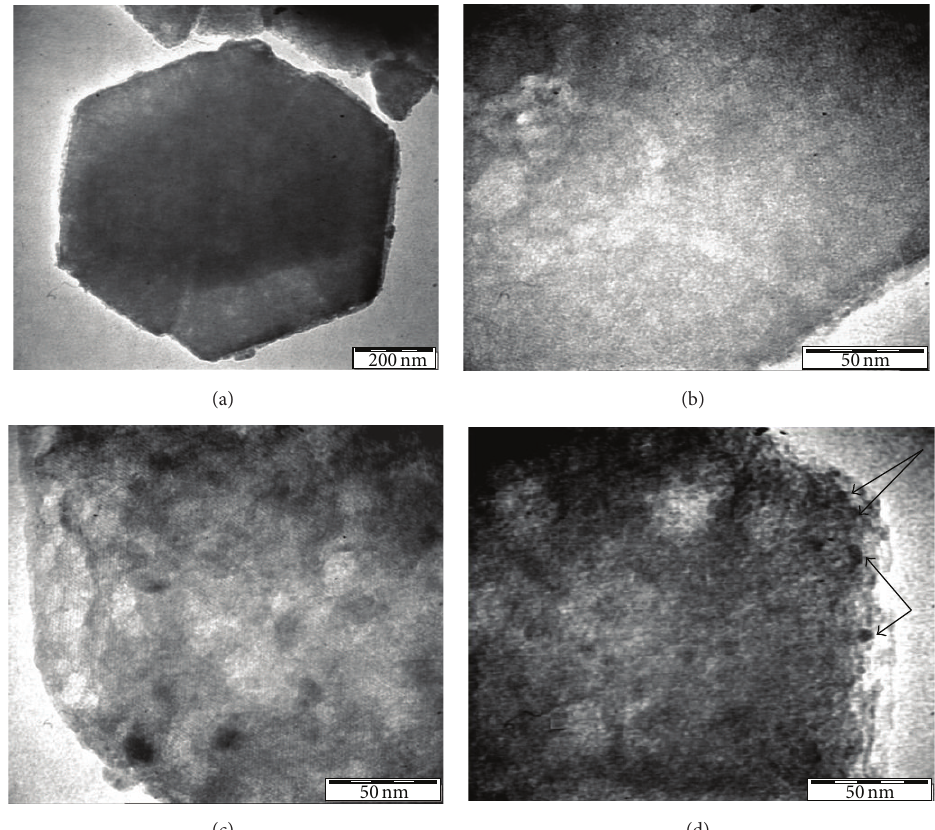
Figure 5: TEM images for NaY ((a) and (b)) at 8k and 45 k magnification, respectively, (c) Ti 4 -NaY, and (d) 0.64% La/Ti 4